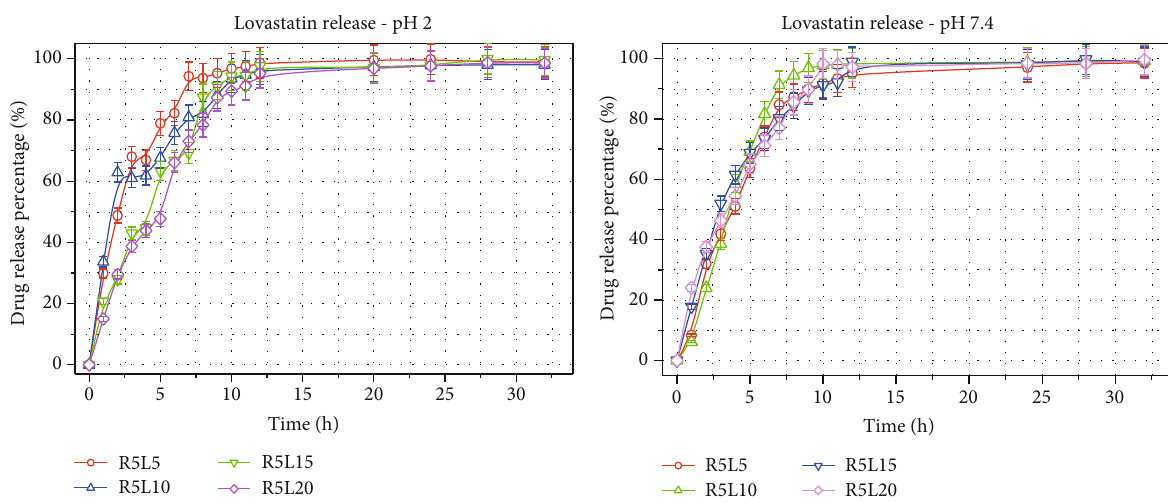
Figure 12: Percentage of Lov released from NPB-R5Ly samples in pH 2 and pH7.4